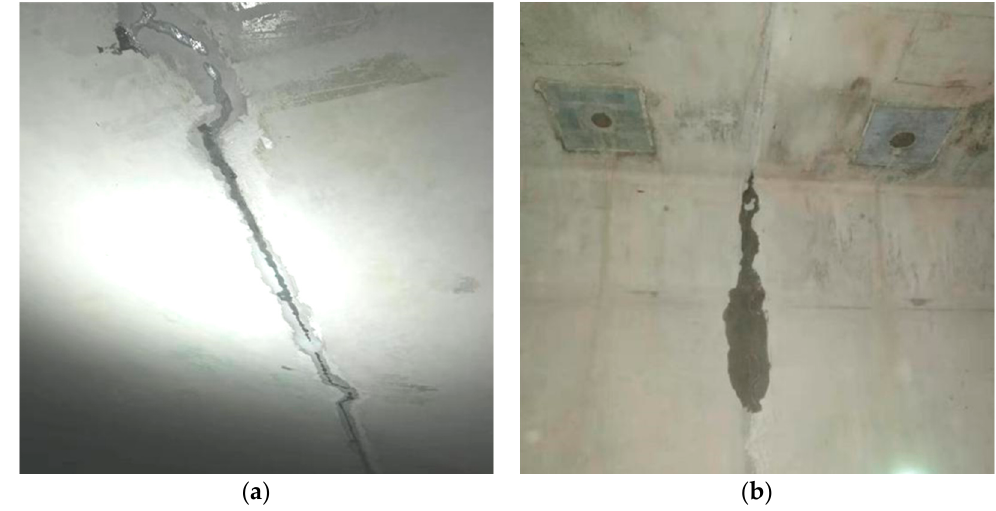
Figure 1. Leakage in the box girder of a newly constructed precast segmental bridge. ( a ) Leakage in the top flange; ( b ) Leakage in the web.